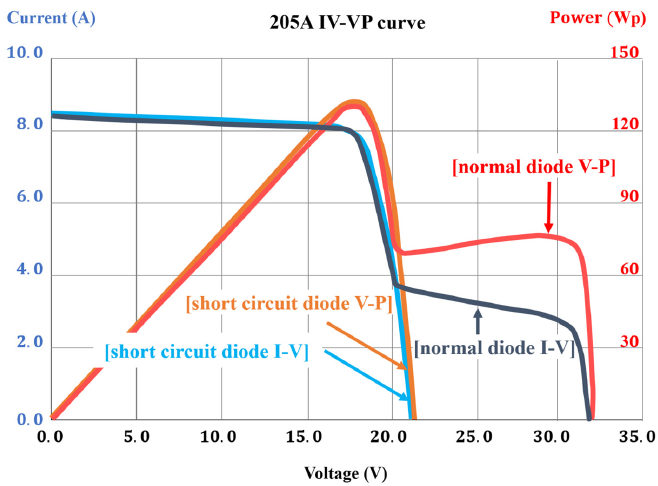
Figure 11. I–V and V–P curves before and after replacement of short-circuit diode (205A).